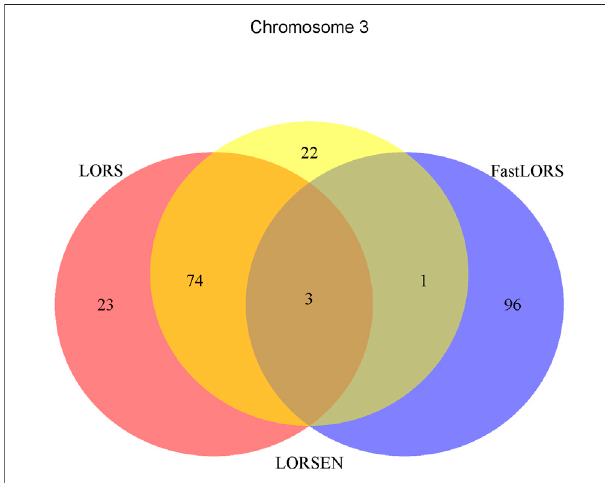
FIGURE 1 | The top 100 SNP-probe pairs identi fi ed by FastLORS, LORSEN, and LORS on Chromosome 3.